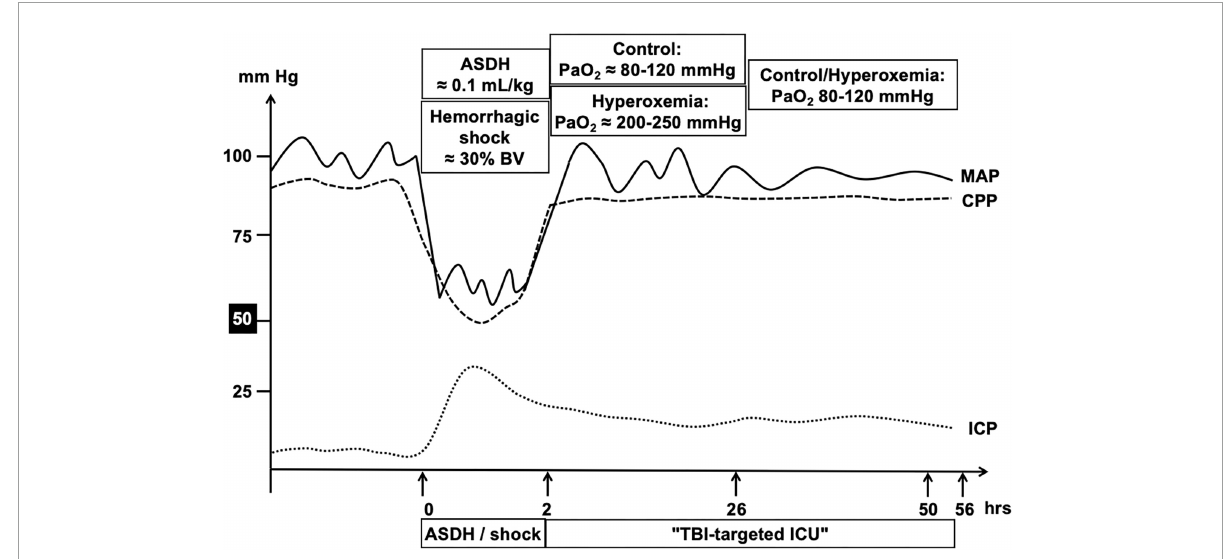
FIGURE1 Schematic summary of the experimental design. After instrumentation and a resting period, ASDH was induced by injection of 0.1 ml/kg autologous blood into the subdural space. Immediately after induction of ASDH, hemorrhagic shock was initiated by passive removal of blood targeting 30% of the calculated blood volume. Blood removal was slowed down if necessary to maintain cerebral perfusion pressure (CPP), i.e., the difference between the simultaneously measured mean arterial (MAP) and intracranial (ICP) pressures, ≥ 50 mmHg. At 2 h of combined ASDH and hemorrhagic shock, resuscitation was initiated comprising re-transfusion of shed blood, fluid resuscitation, and continuous i.v. noradrenaline titrated to maintain MAP at pre-shock levels and CPP ≥ 75 mmHg over a maximum of 54 h. Animals were randomly assigned to control (normoxemia, P a O 2 ≈ 80 – 120 mmHg throughout the whole observation period) vs. targeted hyperoxemia (P a O 2 ≈ 200 – 250 mmHg during the first 24 h of treatment, thereafter similar to the control